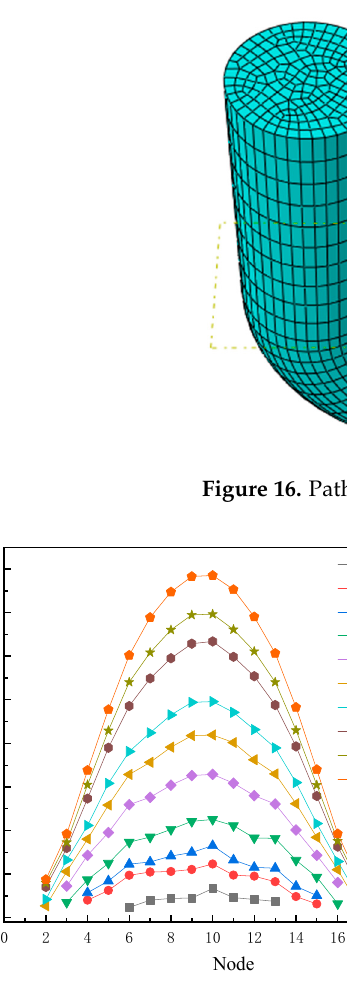
Figure 15. Change of wear area with wear times.